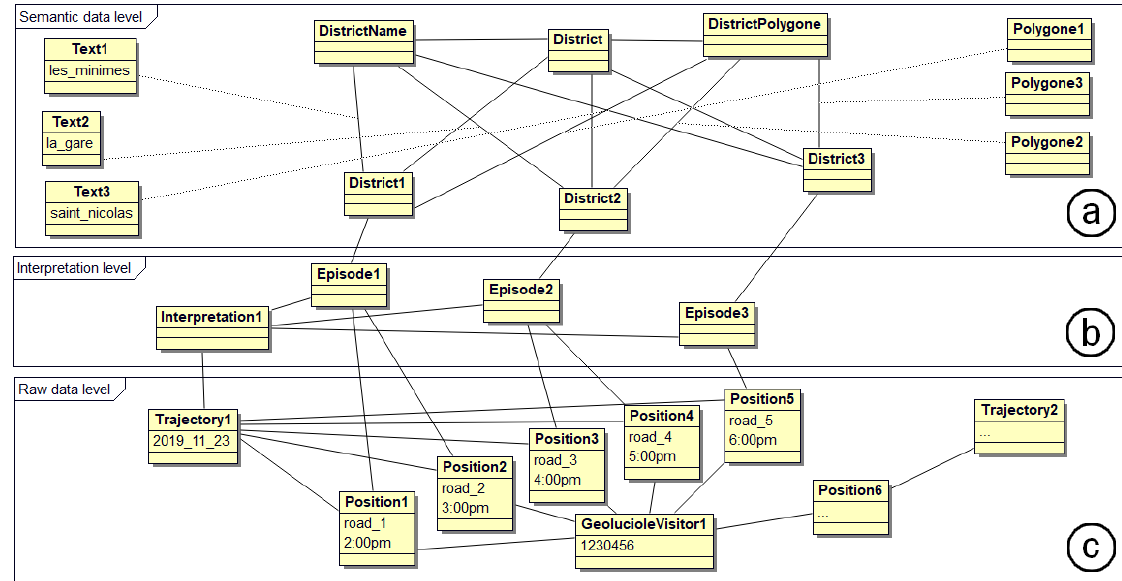
Figure 5. Instantiation of the model just before the filtering process to answer question